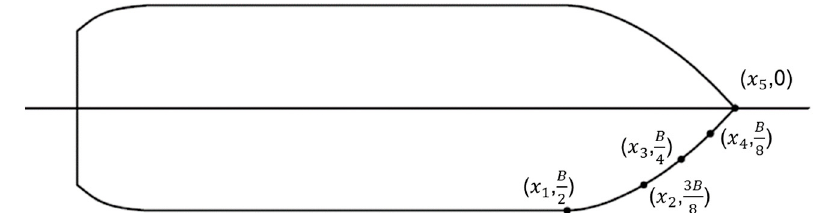
Figure 3. Bow discretization and locations considered in the